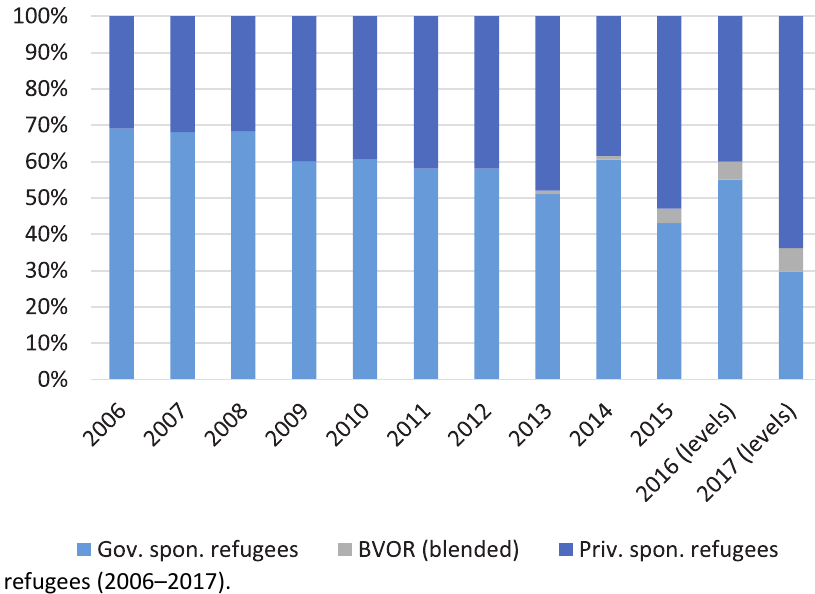
Figure 1. Resettled refugees